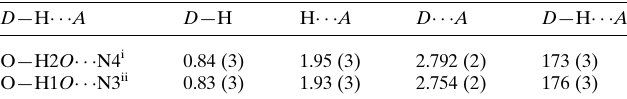
Table 1 Hydrogen-bond geometry (A˚ , (cid:5)